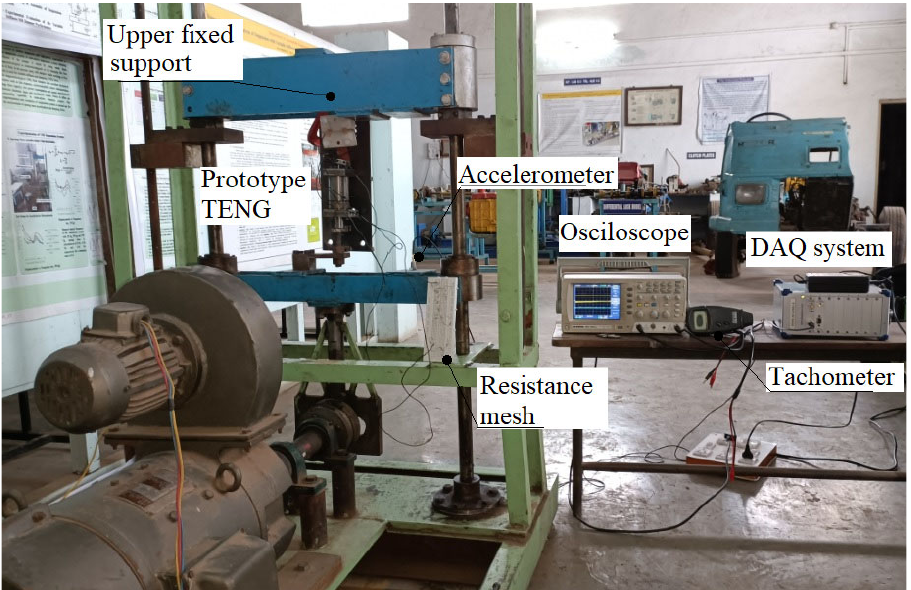
Figure 10. Experimental test setup.